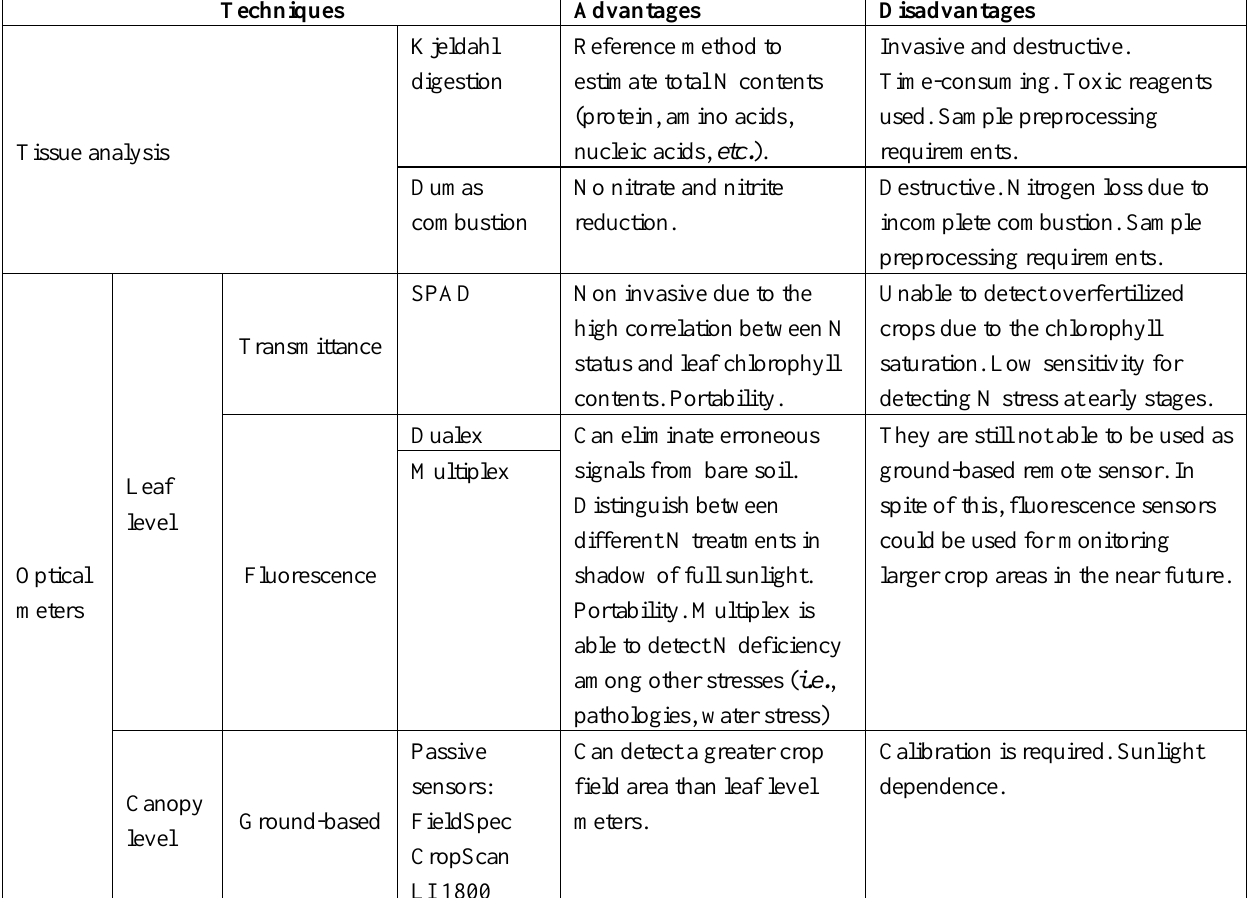
Table 1. Advantages and disadvantages of plant N sensing techniques